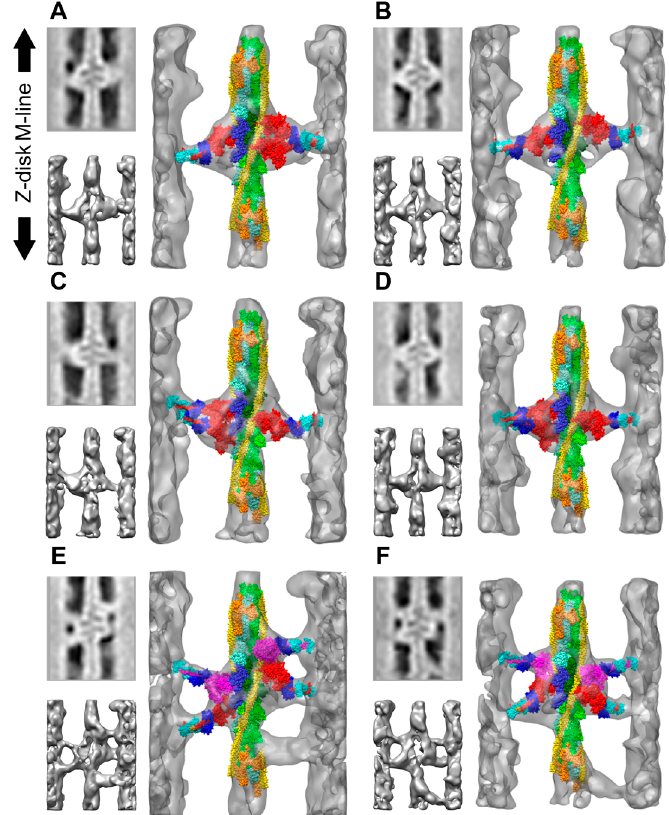
Figure 7. Class averages and quasi-atomic models of a selection of class averages from the Lethocerus flight muscle in an isometric contraction. Small panels to the left are the central section (top) and an opaque isodensity surface view (bottom) of the larger panel. In the translucent larger panel, actin long pitch strands are cyan and green with the target-zone actins in darker shades, TM is yellow and Tn orange. Heavy chains of strongly bound myosin heads are colored red, weak binding myosin heads magenta, ELC dark blue and RLC light blue. ( A ) Single headed cross-bridge on the left and a 2-headed, strong-binding cross-bridge on the right; ( B ) a pair of 1-headed, strong-binding cross-bridges on actin subunits H and I; ( C , D ) a strongly bound 2-headed cross-bridge on the left and a strongly bound 1-headed cross-bridge on the right. ( E , F ) are mask motifs with Tn-bridges. Tn-bridges have not been fit with a myosin head; ( E ) the right, M-ward side, cross-bridge is a weak binding Type 2 bridge outside of the target zone contacting TM near actin subunit F, while on the left is a Type 1 weak-binding cross-bridge within the target zone on actin subunit I. ( F ) On the M-ward left side is a Type 2 weak-binding, cross-bridge contacting TM outside the target zone near actin subunit G, while the Type 1, weak-binding cross-bridge on the right is contacting target-zone actin subunit H. From [34].